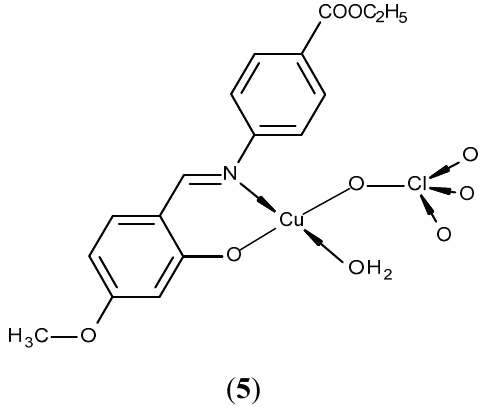
Figure 2. Proposed structures for the copper(II) complexes 1 – 5 .